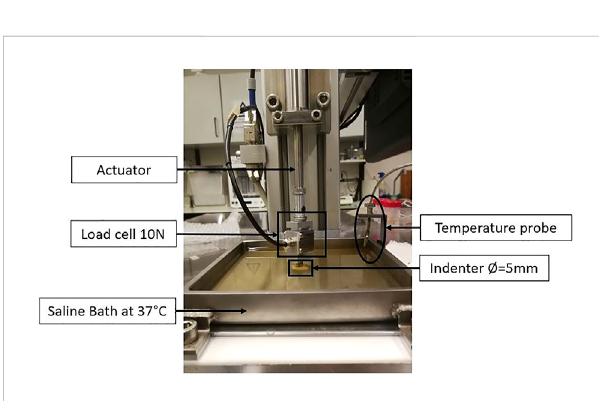
FIGURE 6 Example of an ex-vivo experimental setup to test human breast tissue samples, using a saline bath at 37 ° C, an indenter with 5 mm of diameter, and a load cell of 10N. Adapted from (Teixeira et al.,